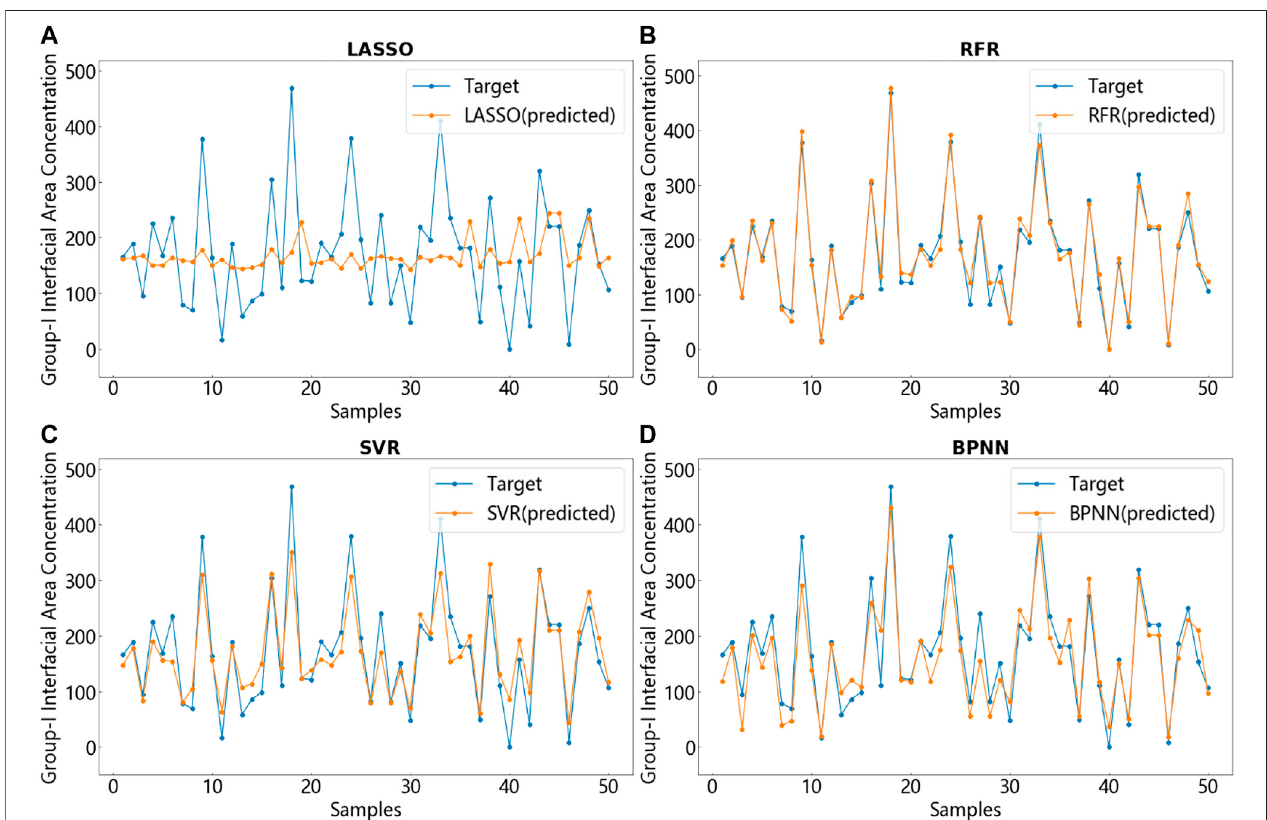
FIGURE7 | Prediction ofthe group-Iinterfacialarea concentration using four models and comparison with target values. (A) LASSO. (B) RFR. (C) SVR (D) BPNN.